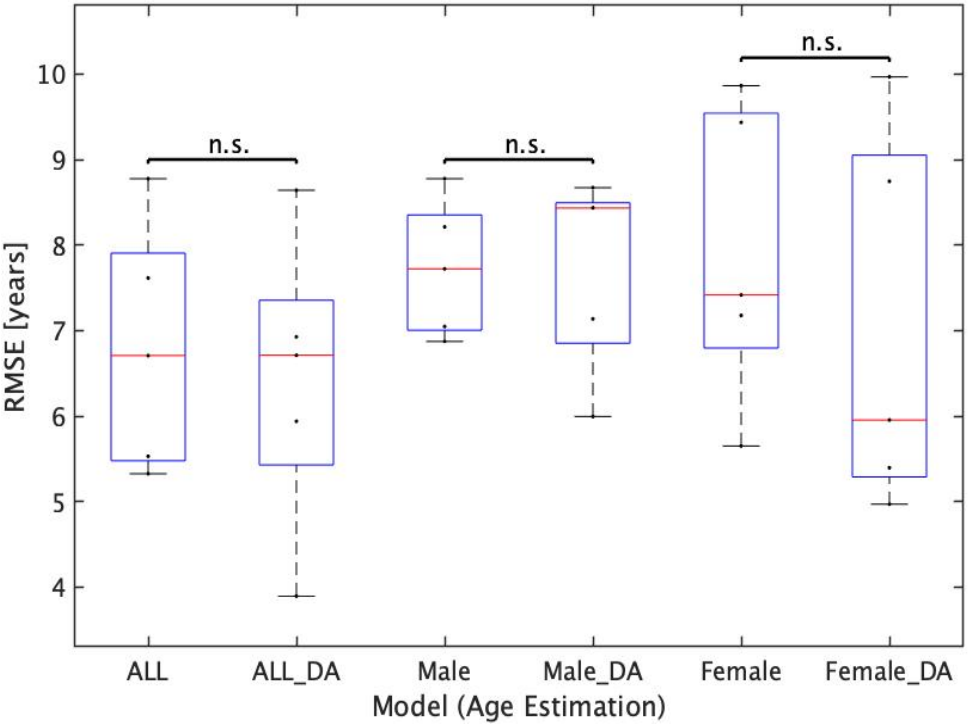
Figure 8. Results for root mean squared error (RMSE). (DA: Data Augmentation).